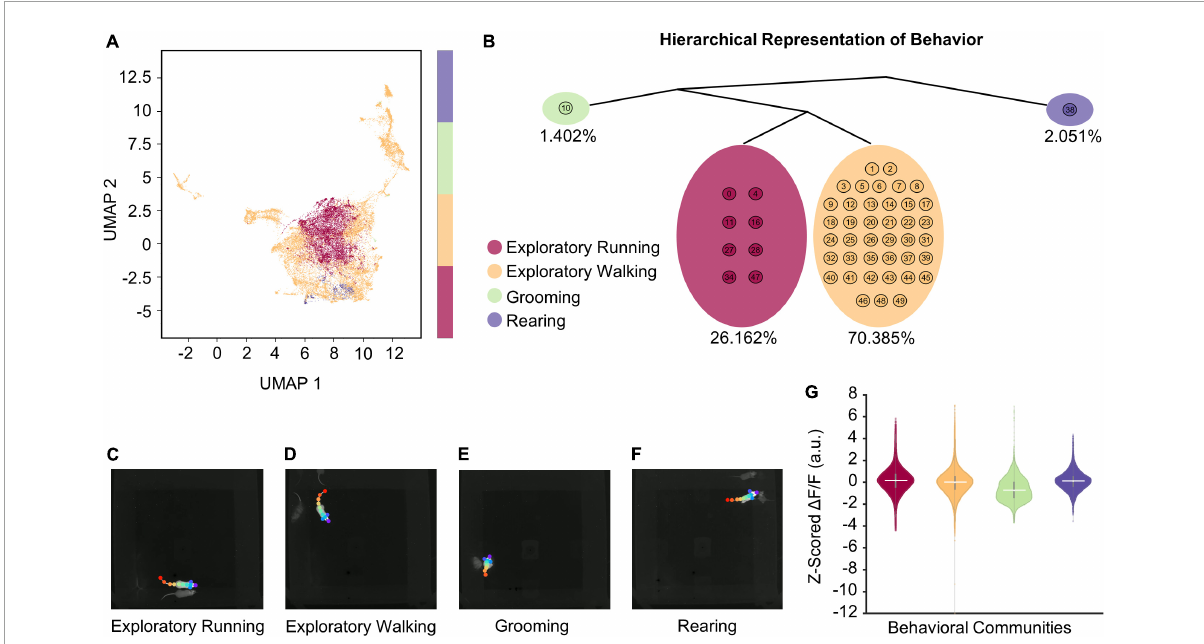
FIGURE4 VAME reveals four distinct behaviors during open field exploration. (A) Unifold Manifold Approximation (UMAP) embedding of the latent representation encoded from VAME’s recurrent neural network, color-coded based on four human expert-labeled behavioral communities corresponding to exploratory running, exploratory walking, grooming, and rearing. (B) Hierarchical representation of the four communities of behavioral motifs in (A). Percentages below each community highlight the time duration observed for that behavior across a total of 10 h of open field exploration ( n = 74 sessions). (C–F) Representative video frames for each behavioral community identified with VAME. Videos showing examples of behavioral activities for each identified community are provided in Supplementary material . (G) Z-scored (cid:49) F/F associated with each behavioral community. Horizontal solid white lines indicate the medians (see Table 6 for statistics).